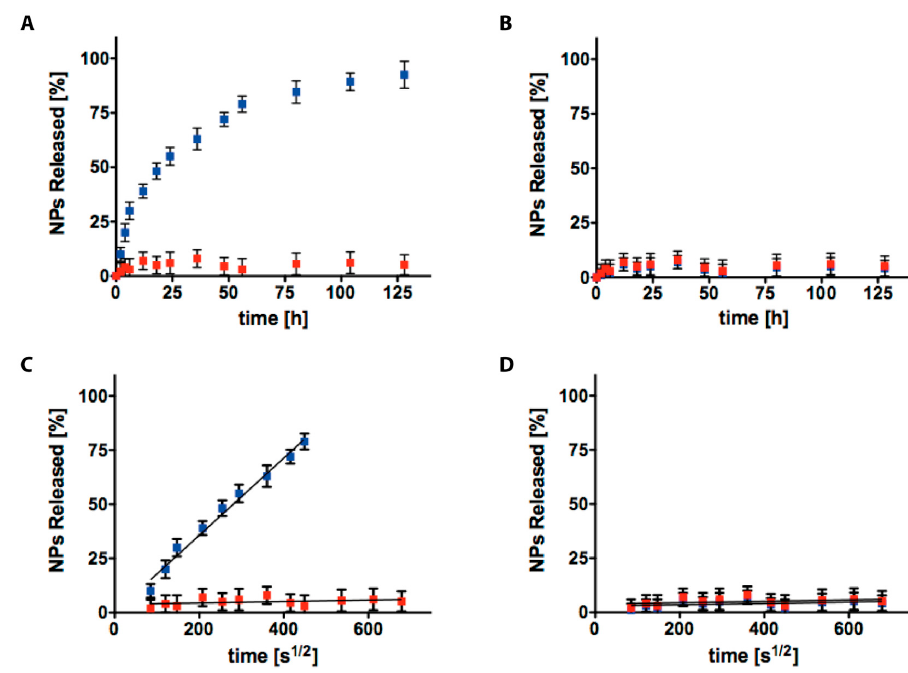
Figure 4. Cumulative release of NPs with different electric charges (negative, blue squares and positive, red squares) from AC6 hydrogel at pH = 7.4 ( A ) and pH = 5 ( B ); the slope of NPs released from AC6 hydrogel against the square root of time represents the role of NPs electric charges in mass transport at pH = 7.4 ( C ) and pH = 5 ( D ). The values are calculated as a percentage, with respect to the total mass loaded (mean value ± standard deviation is plotted).